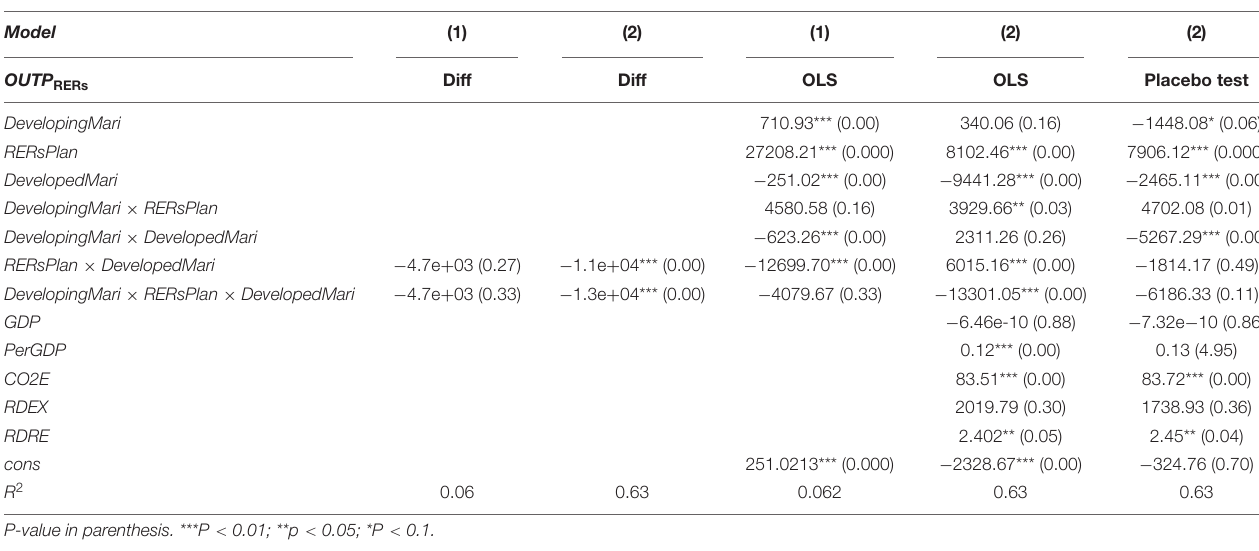
TABLE 2 | Regression results of DDD model.